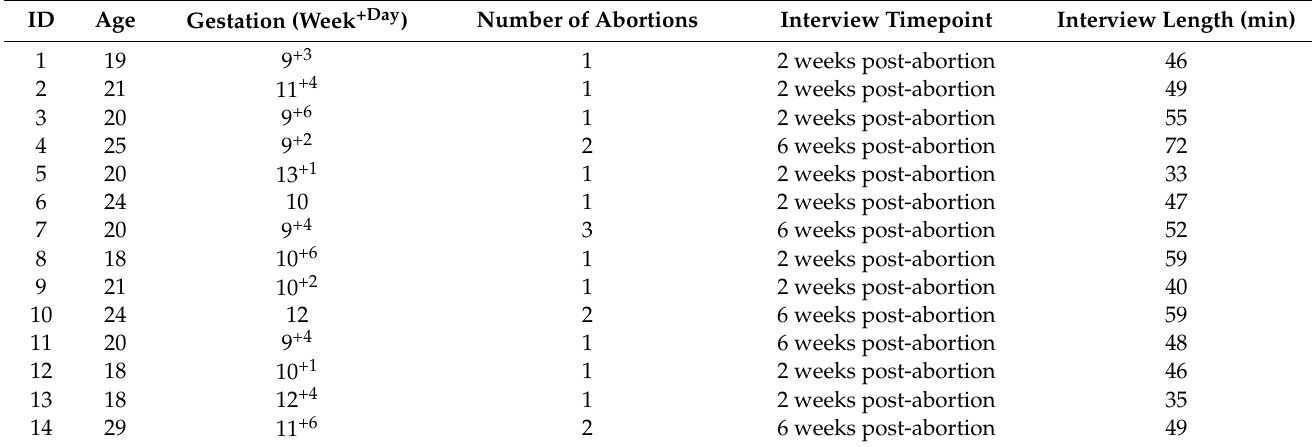
Table 1. Demographic, reproductive, and interview characteristics of